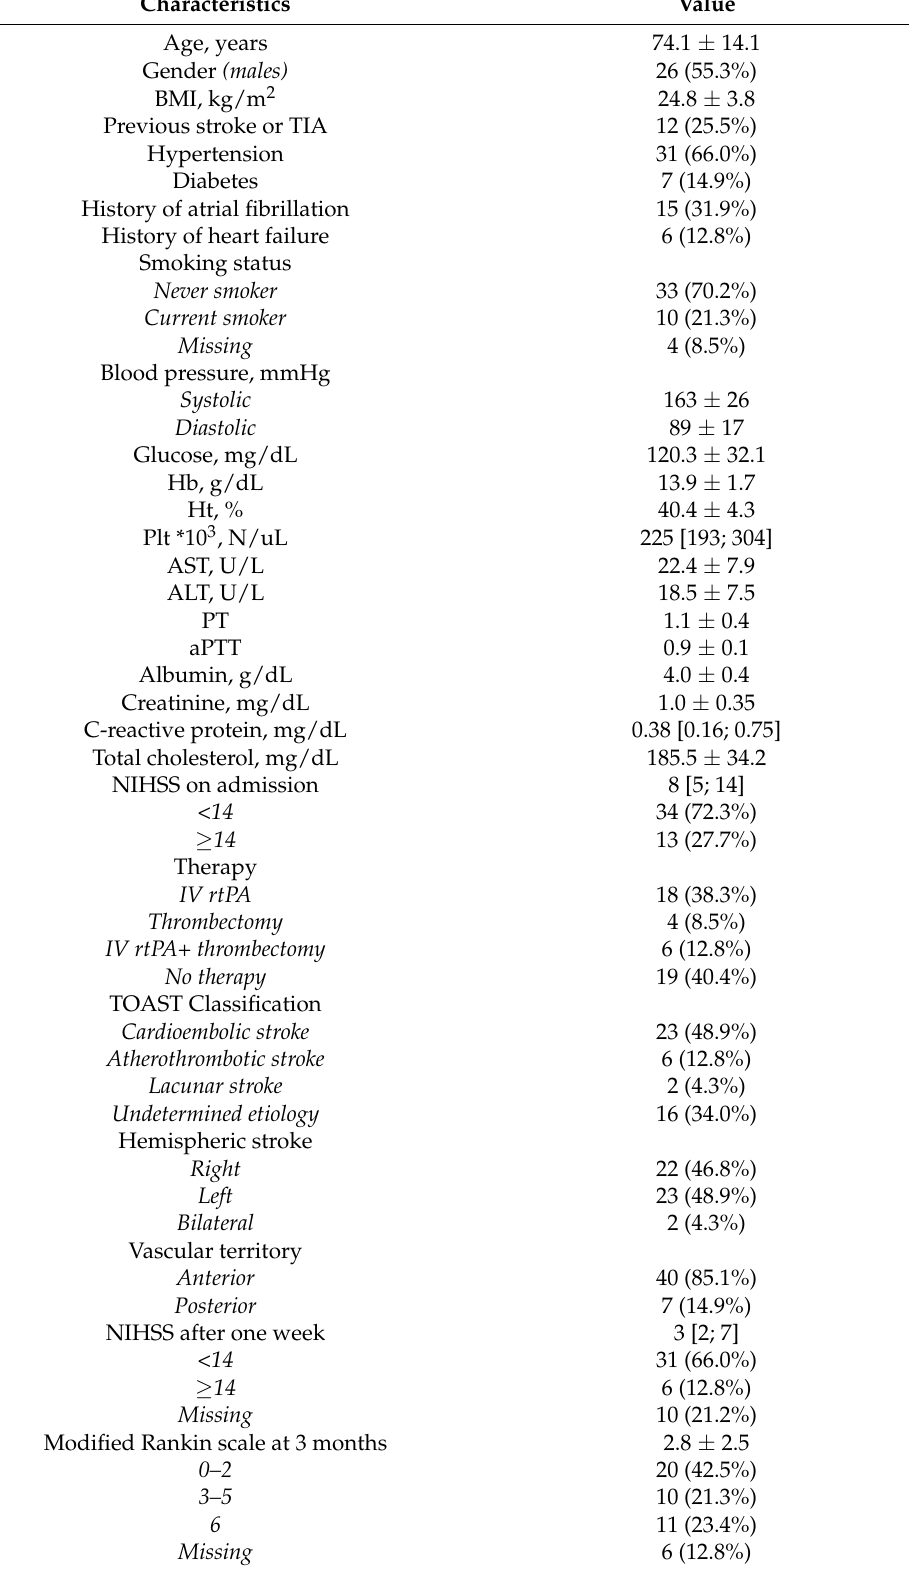
Table 1. Demographic and clinical characteristics of the studied population ( n =